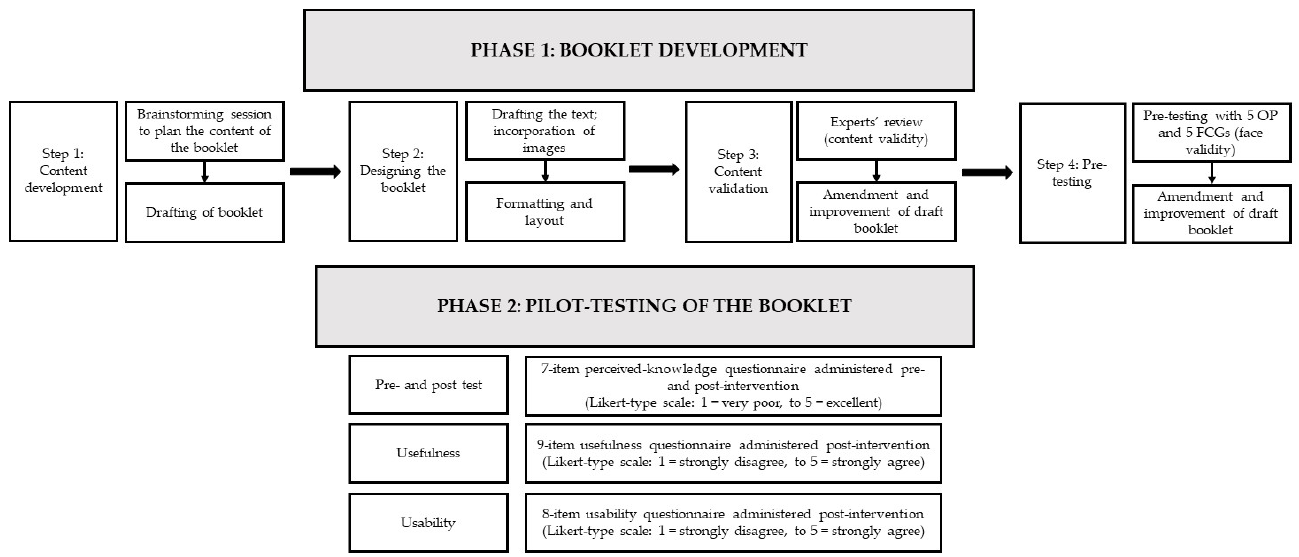
Figure 1. Schematic diagram of the methodological steps involved in the study (OP: older people; FCGs: family